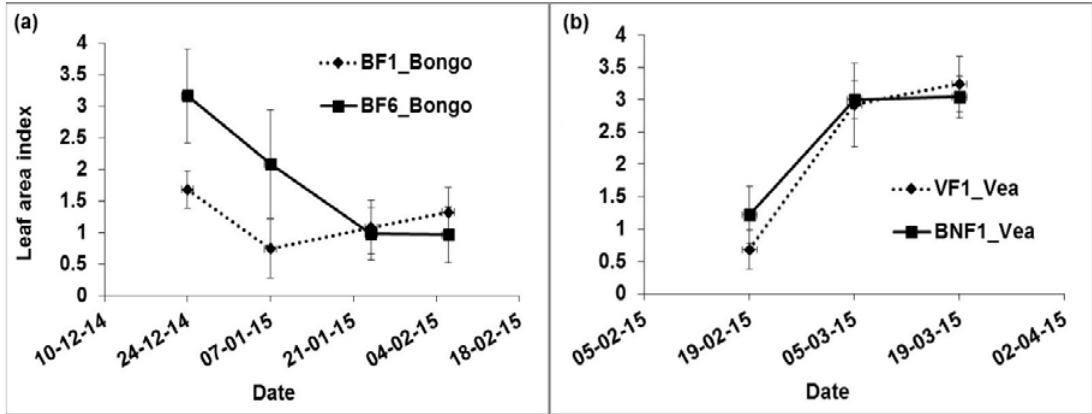
Figure 7. Leaf area index of tomato during the 2014–2015 dry season in the ( a ) Bongo and ( b ) Vea irrigation schemes.